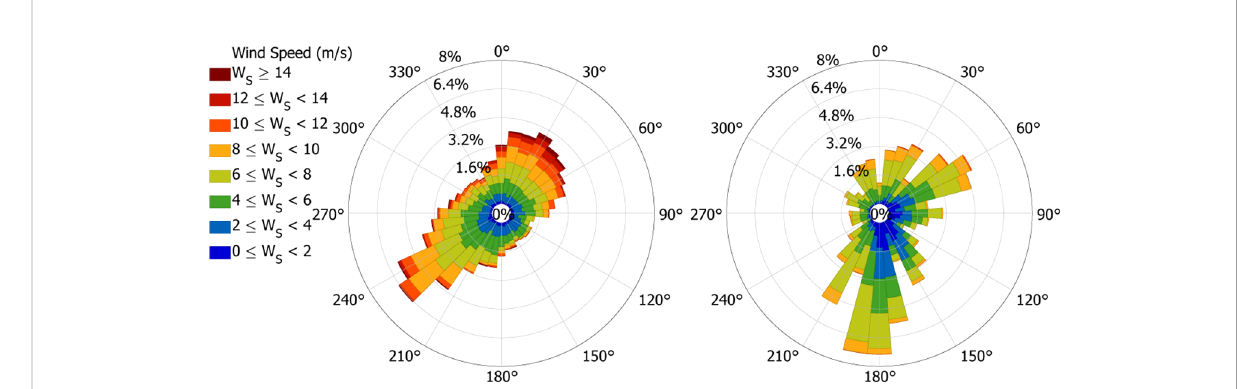
FIGURE 9 Comparison of wind roses for the meteorological buoy (left) and Spotter buoy (right).